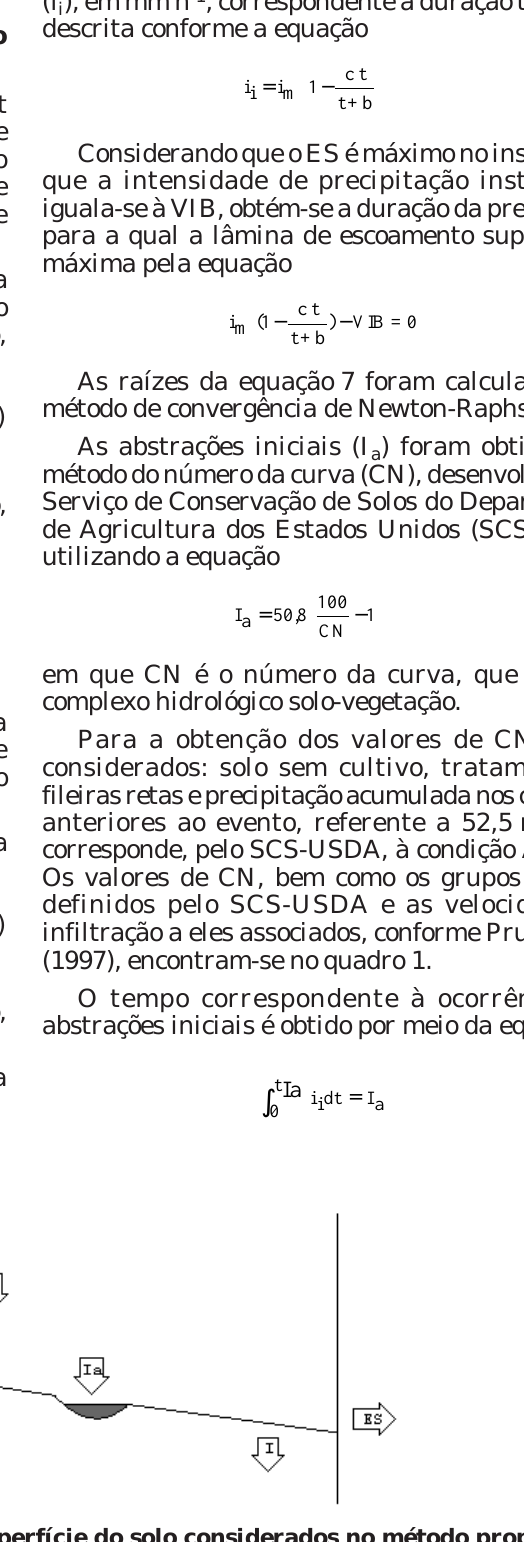
Figura 1. Componentes do balanço de água na superfície do solo considerados no método proposto por Pruski et al. (1997). ev = evaporação (mm); PT = precipitação total (mm); Ia = abstrações iniciais (mm); I = infiltração (mm); e ES = escoamento superficial